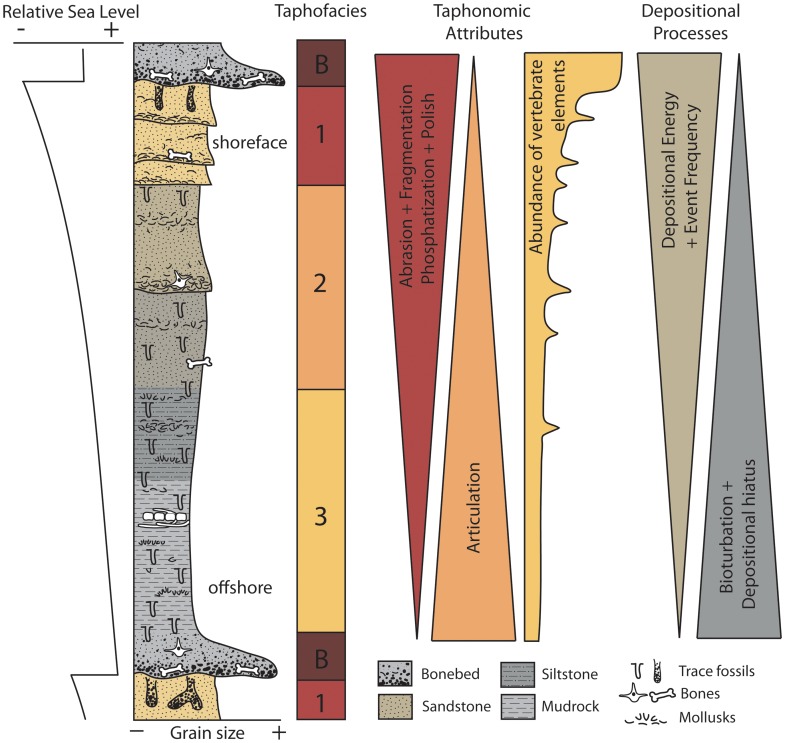
Generalized taphonomic trends within a hypothetical parasequence of the Purisima Formation.This is based chiefly on Section 3, and shows changes in relative sea level, depositional setting, assigned taphofacies, and vertical changes in magnitude of taphonomic attributes and importance of depositional processes.